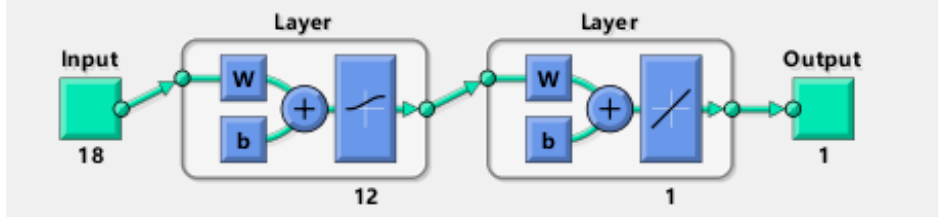
Figure 4. Schematic diagram of network structure.